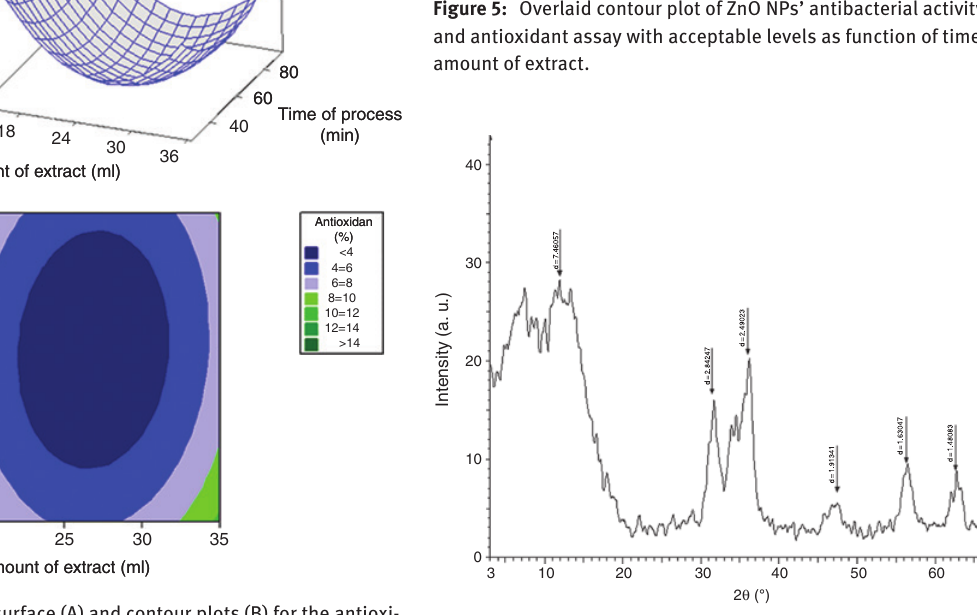
Figure 6: XRD pattern of the synthesized ZnO NPs at optimum